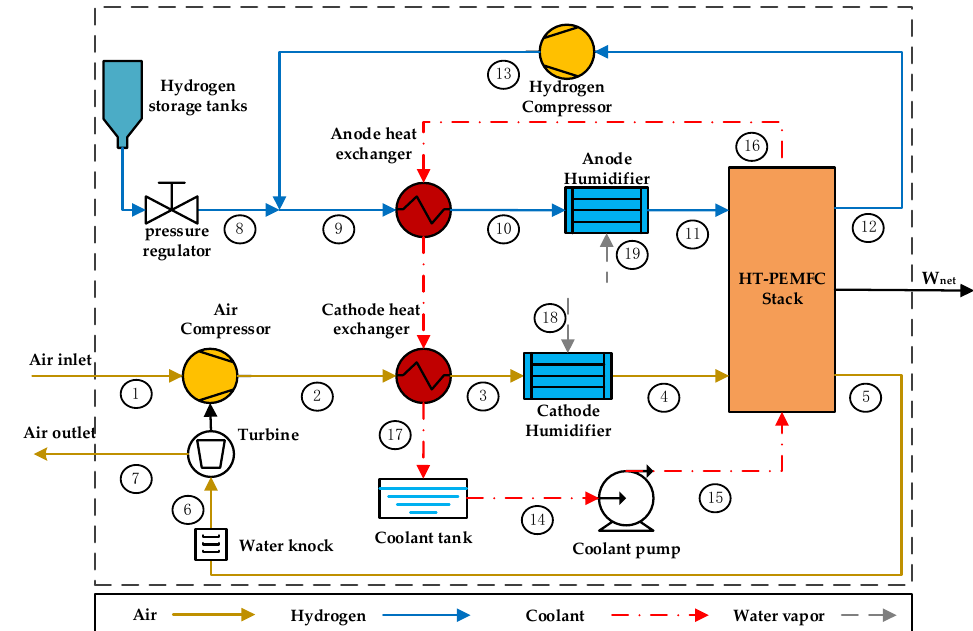
Figure 1. Schematic of the proposed HT-PEMFC system.